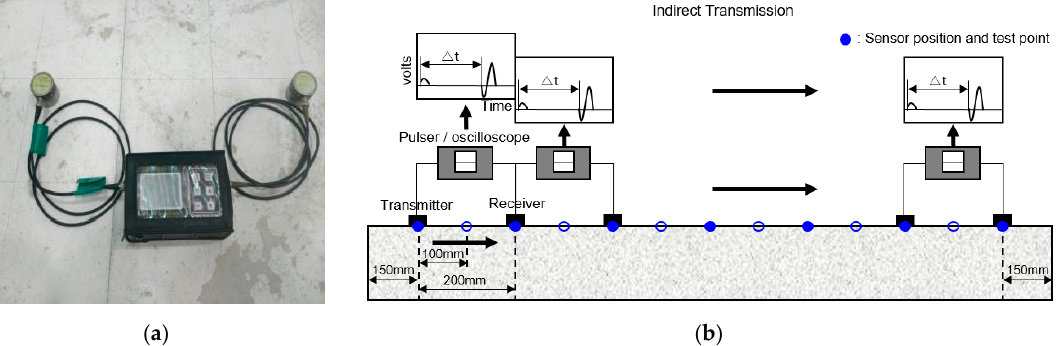
Figure 1. Ultrasonic pulse velocity test method. ( a ) Ultrasonic equipment; ( b ) Procedure of P-wave measurement.